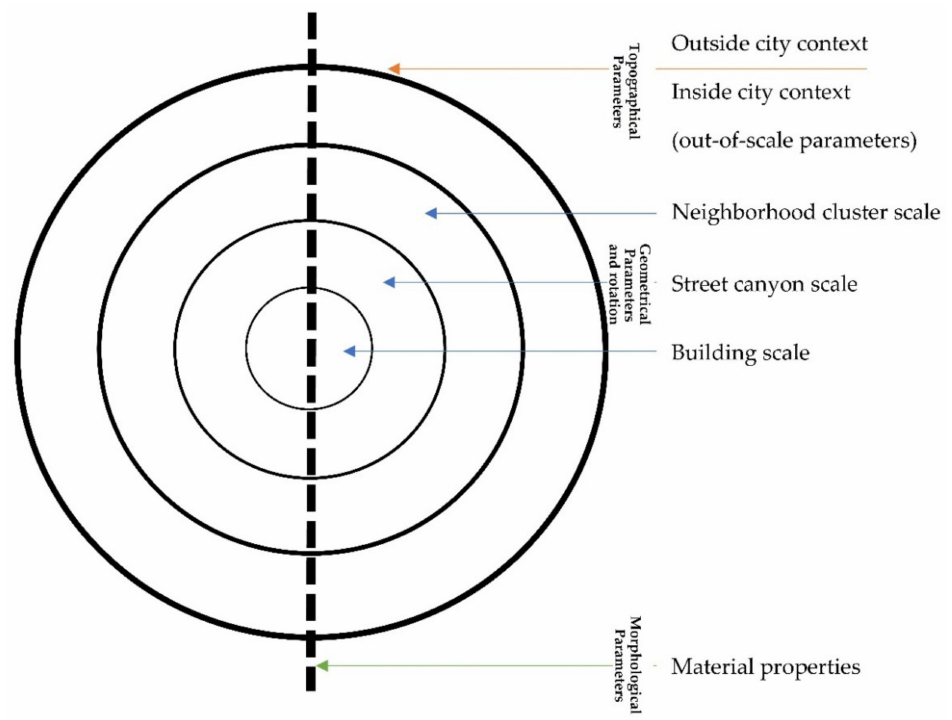
Figure 2. Logical diagram of the hierarchy and relationships between scales and parameters’